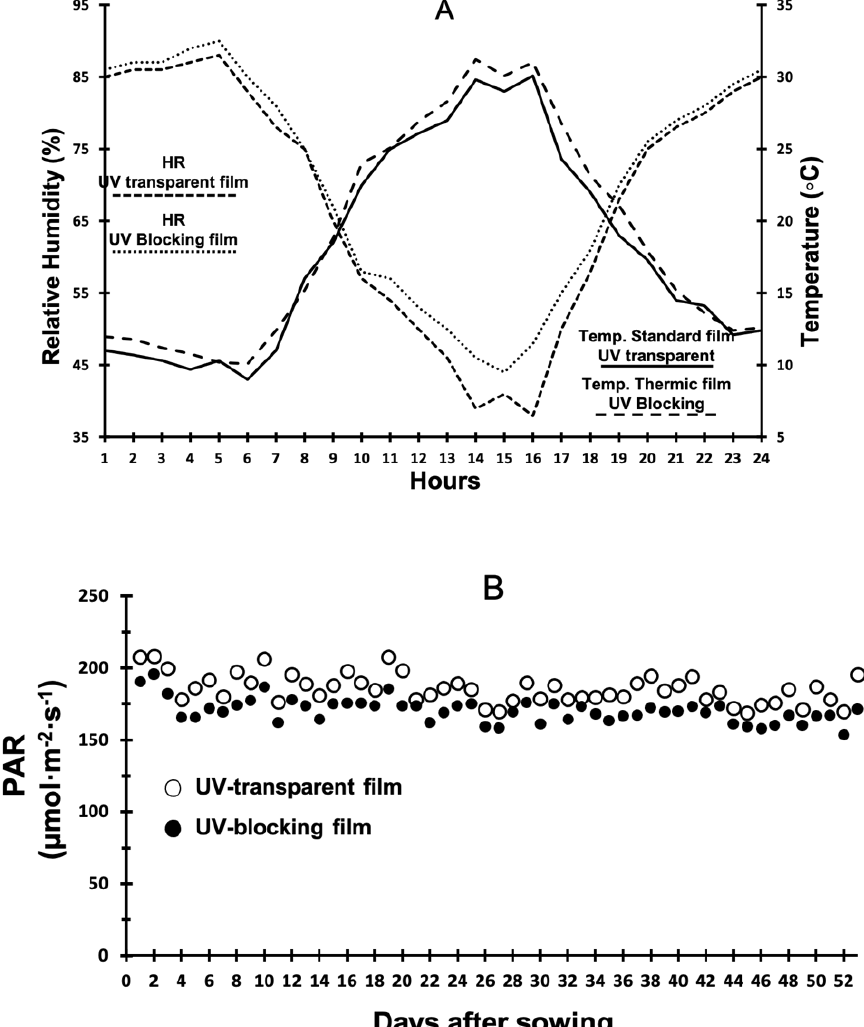
Figure 2. ( A ) Hourly average air temperature ( ◦ C) and relative humidity (%) inside the greenhouses; data were taken through crop cycle. ( B ) daily photosynthetically active radiation (μmol·m −2 ·s −1 ).